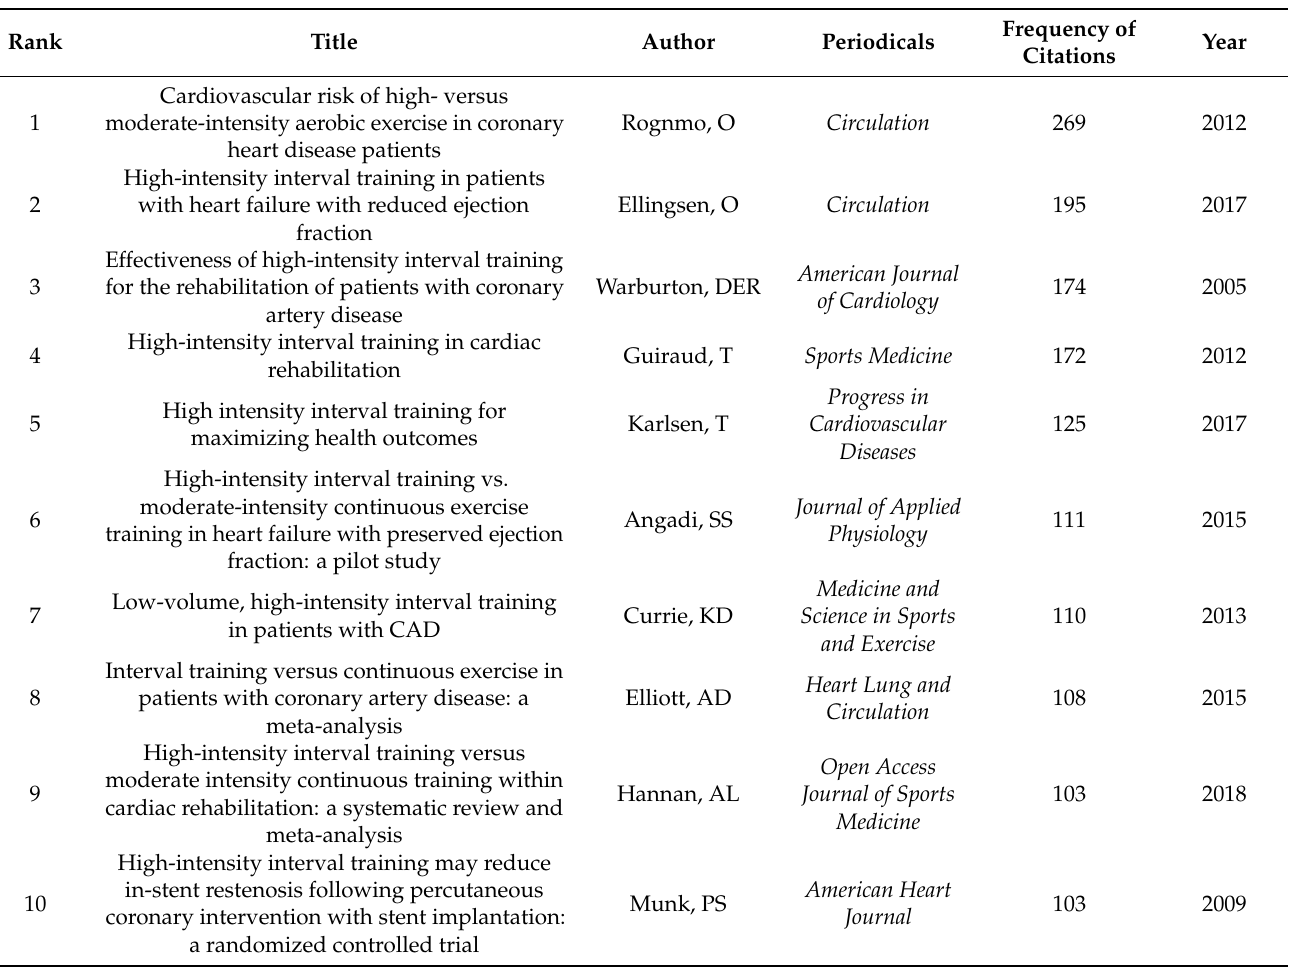
Table 3. Top 10 papers with the most